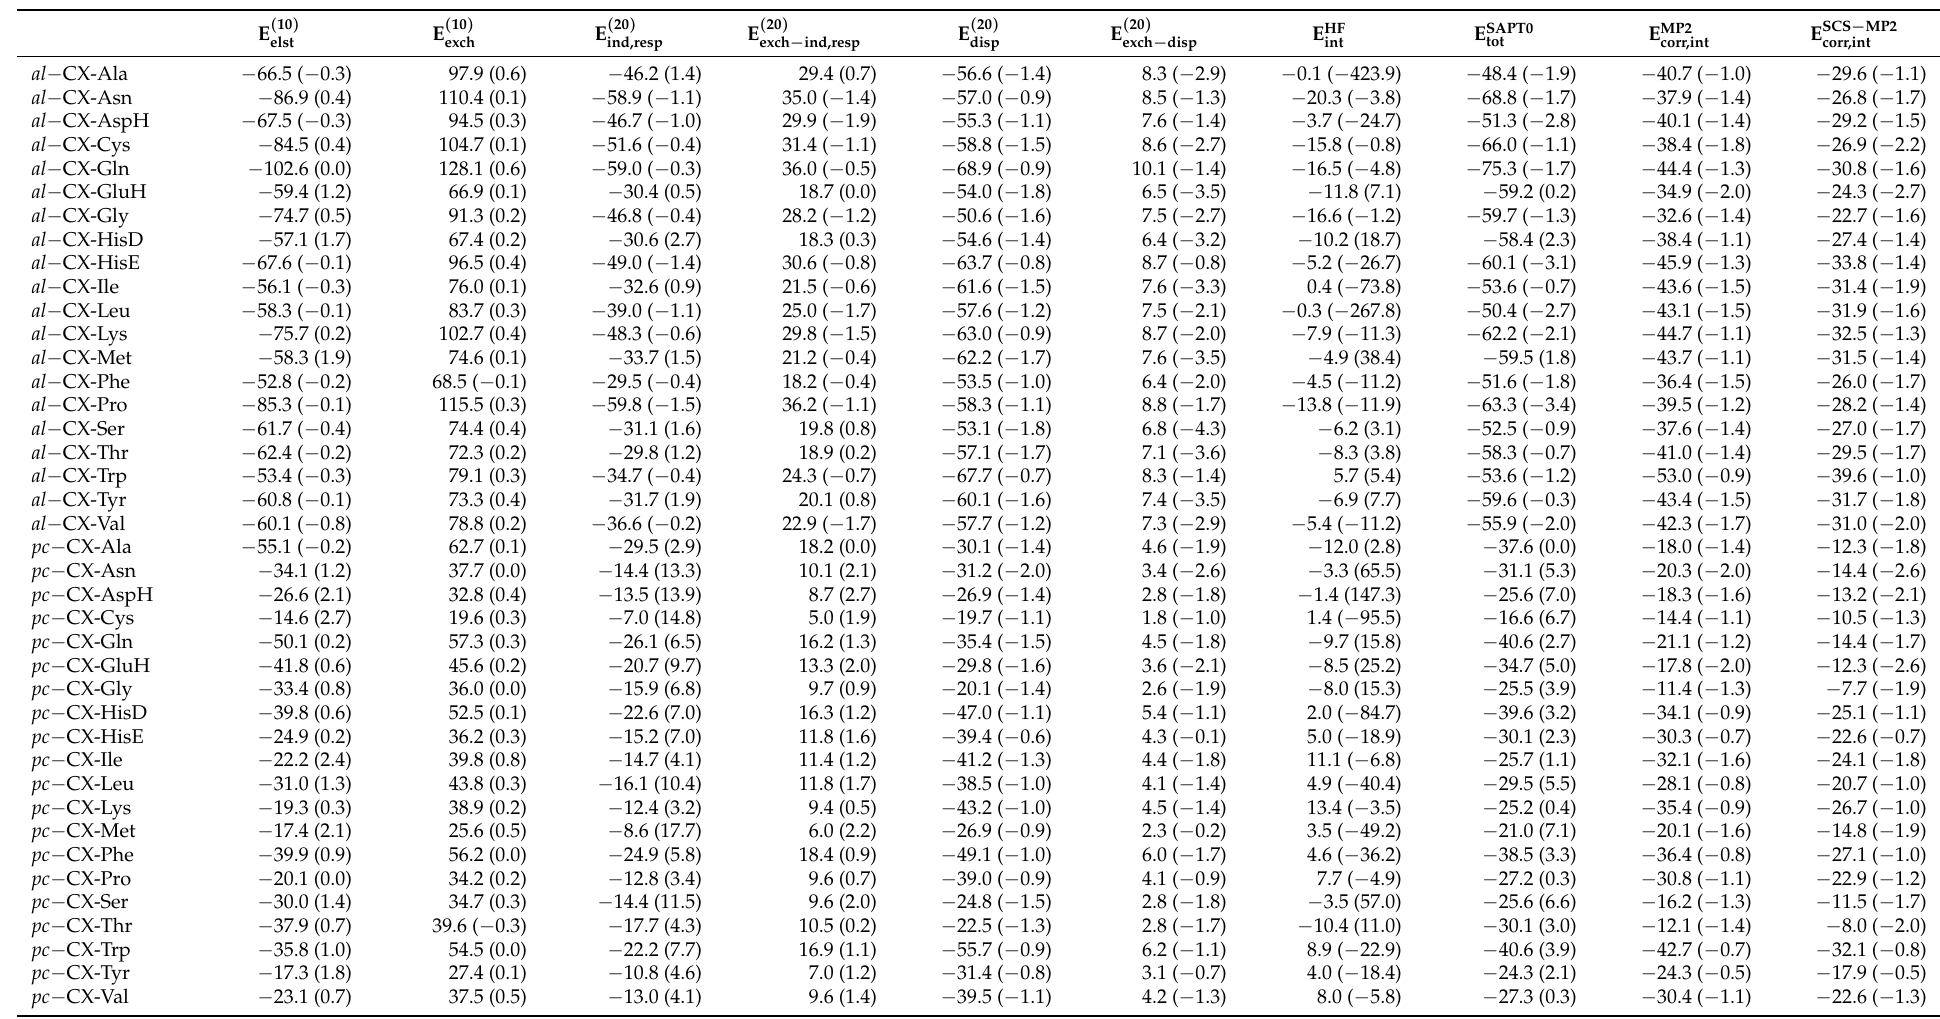
Table 2. The SAPT0 energy components, SAPT0 and HF interaction energies, MP2 and SCS-MP2 electron-correlated parts of the interaction energies for CX + amino acid complexes. The percent errors of the SSMF3 fragmentation scheme are given in parentheses. Energies in